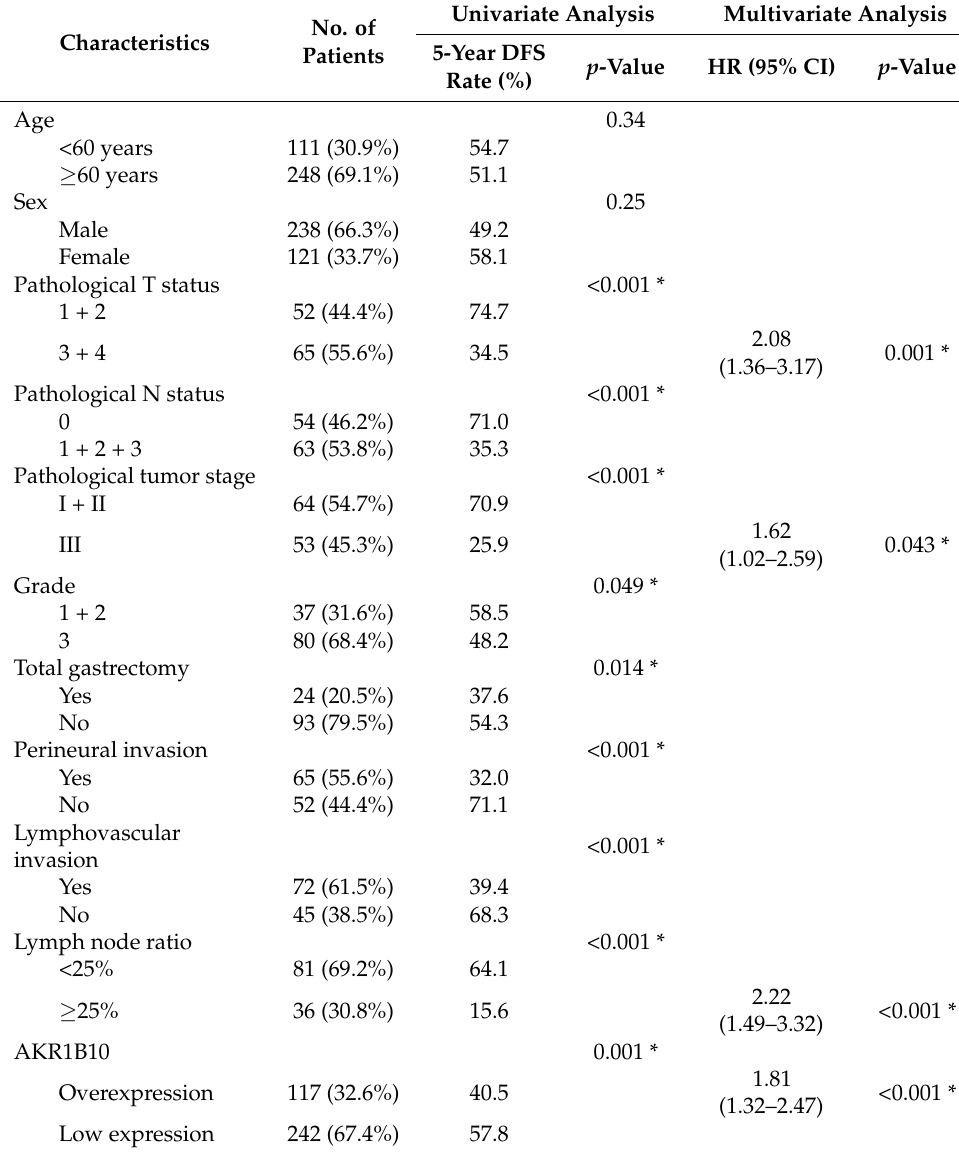
Table 3. Univariate and multivariate analyses of disease-free survival (DFS) in 359 gastric adenocarci- noma patients receiving gastrectomy. Univariate No. of Characteristics Patients